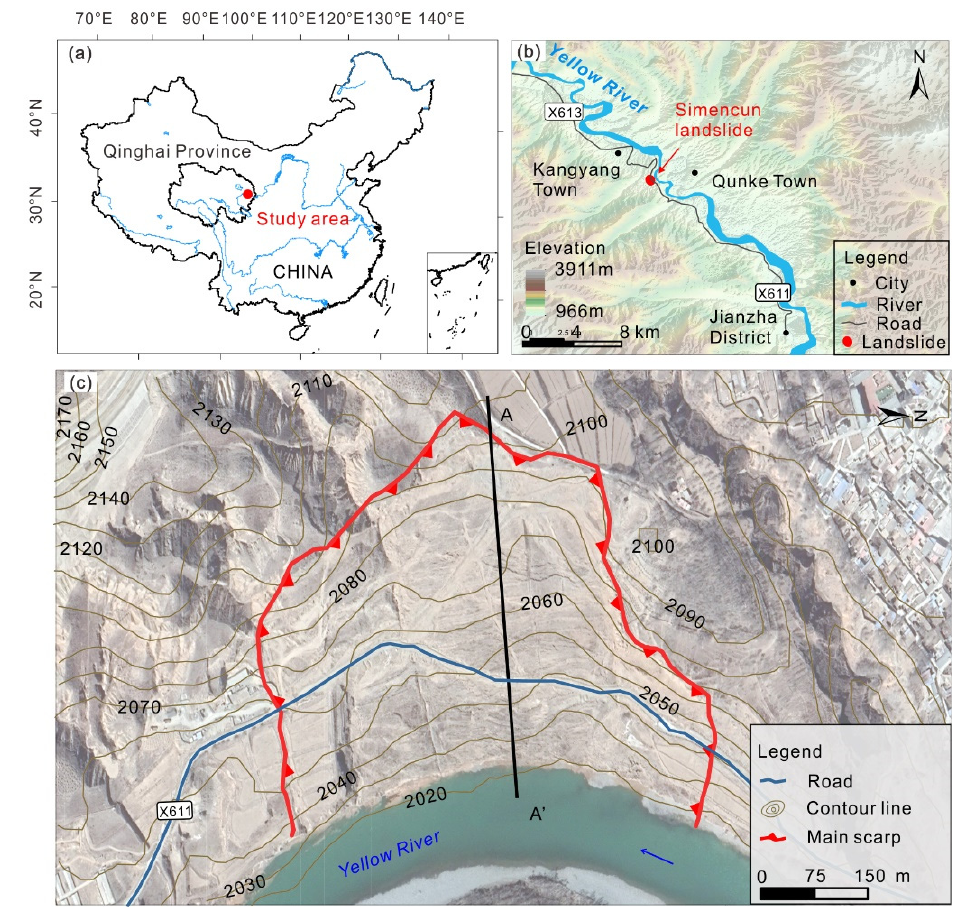
Figure 1. ( a , b ) Location of the Simencun landslide. ( c ) Geomorphological features of the Simencun landslide.